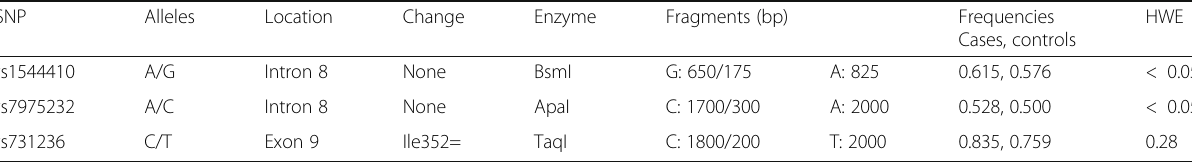
Table 1 Information of the three single nucleotide polymorphisms of VDR